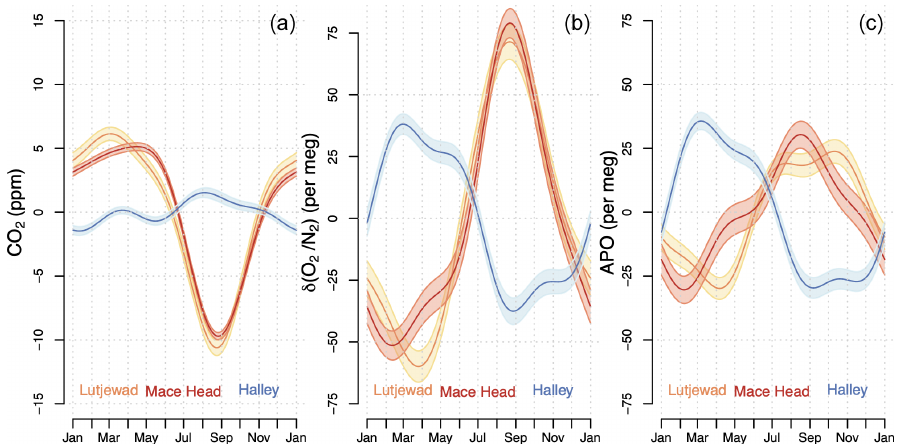
Figure 10. The detrended average seasonal cycles of CO 2 (a) , δ (O 2 / N 2 ) (b) , and APO (c) of stations Lutjewad (plotted in orange), Mace Head (plotted in red), and Halley (plotted in blue). The uncertainty margins (2 σ ) in the fits are indicated by lighter shades of the same colours.